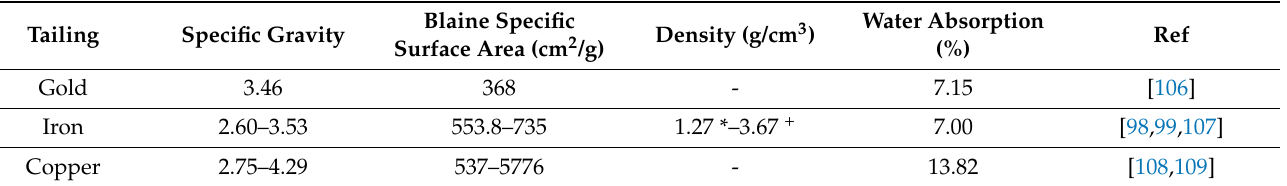
Table 6. Physical properties of various mine tailings ( Note: + indicates the skeletal density through helium pycnometer while * indicates the relative